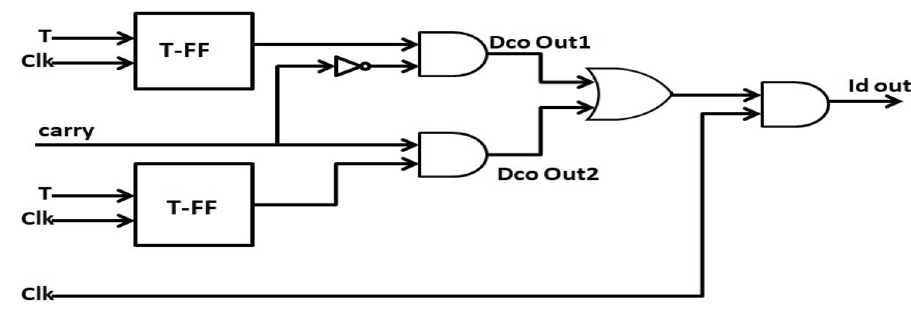
Fig. 6 DCO circuit diagram